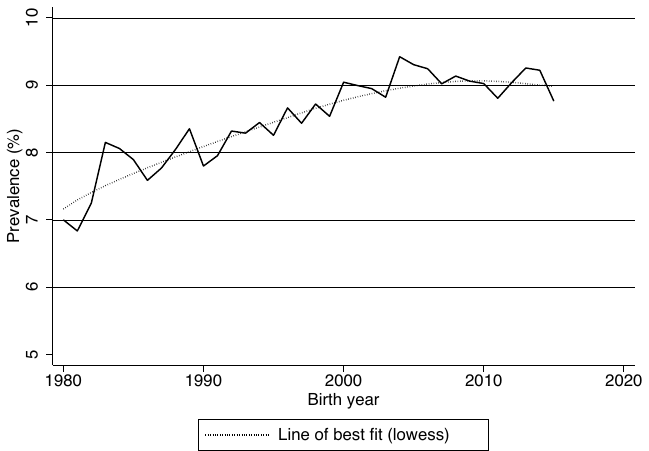
Figure 2. Annual prevalence of preterm birth in Western Australia for the period 1980–2015. Lowess: the local linear smooth plot was generated using Cleveland’s tricube weighting function with a bandwidth of 0.8 (Cleveland, W. S. 1979. Robust locally weighted regression and smoothing scatterplots. Journal of the American Statistical Association 74: